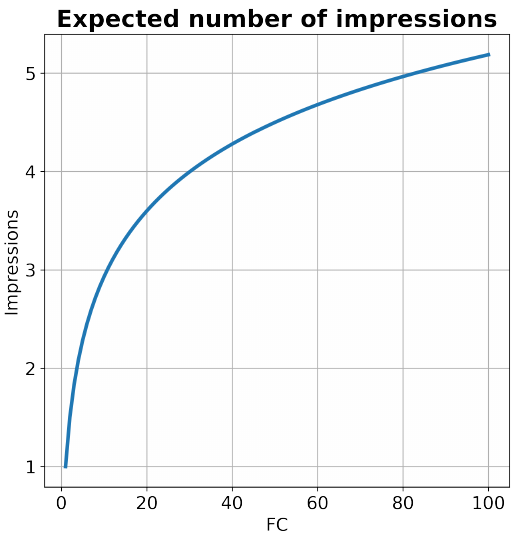
Figure 6. Expected number of impression for each user based on different FC